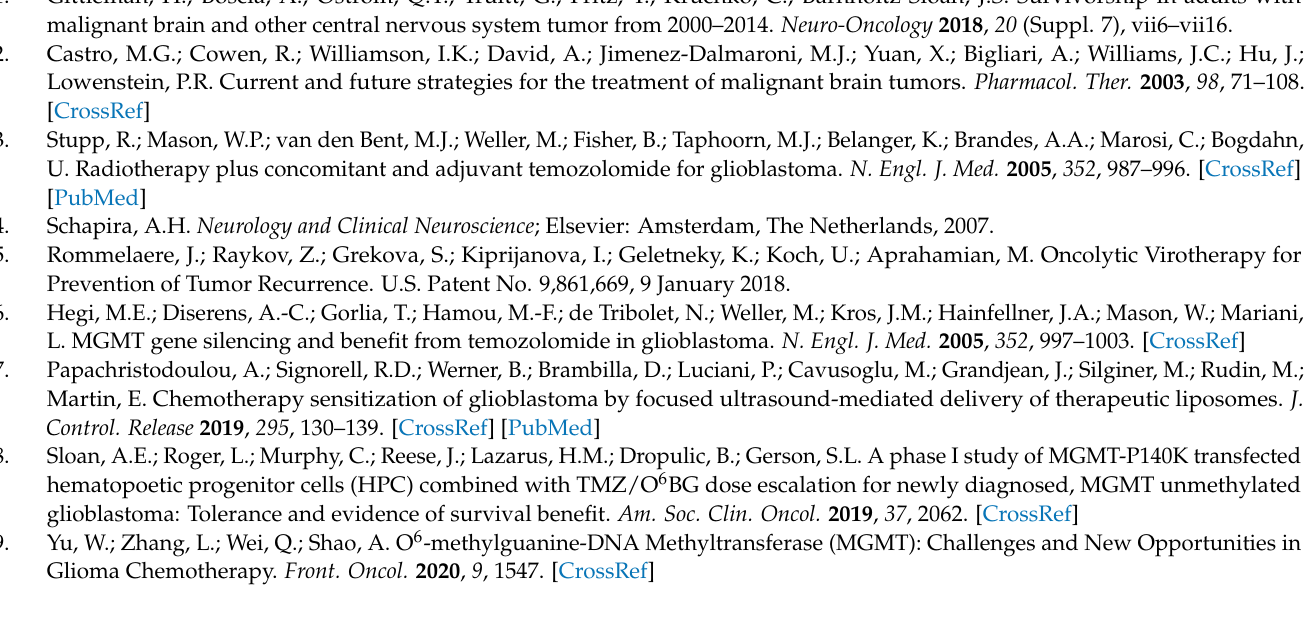
Figure S5: A. Sulfonate modification had minor effect on internalization of Cy5-siRNA carrying polyplexes into U251 cells (2D). B. Inhibition of SELP reduced internalization of APAS:Cy5-siRNA polyplexes into GL261 spheroids, but did not alter the internalization of APA:Cy5-siRNA polyplexes, as obtained by fluorescence activated cell sorting